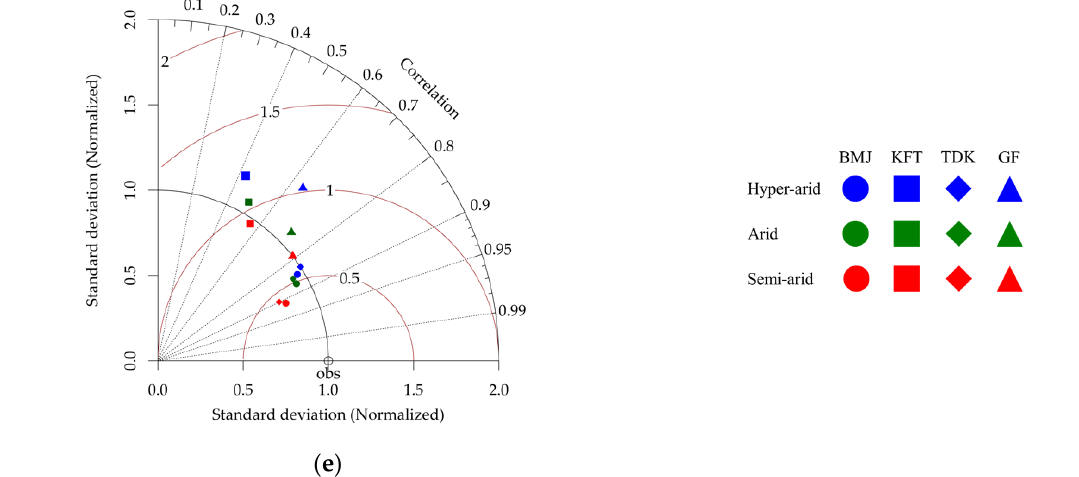
Figure 5. Normalized Taylor diagrams (obs: normalized standard deviation of observations) for monthly and seasonal maximum temperature during the dry season (November–February) in the hyper-arid, arid, and semi-arid zones of Sudan. BMJ, KFT, TDK, and GF are the Betts–Miller–Janjic, improved Kain–Fritch, modified Tiedtke, and Grell–Freitas schemes, respectively. ( a ) November. ( b ) December. ( c ) January. ( d ) February. ( e ) November–February.